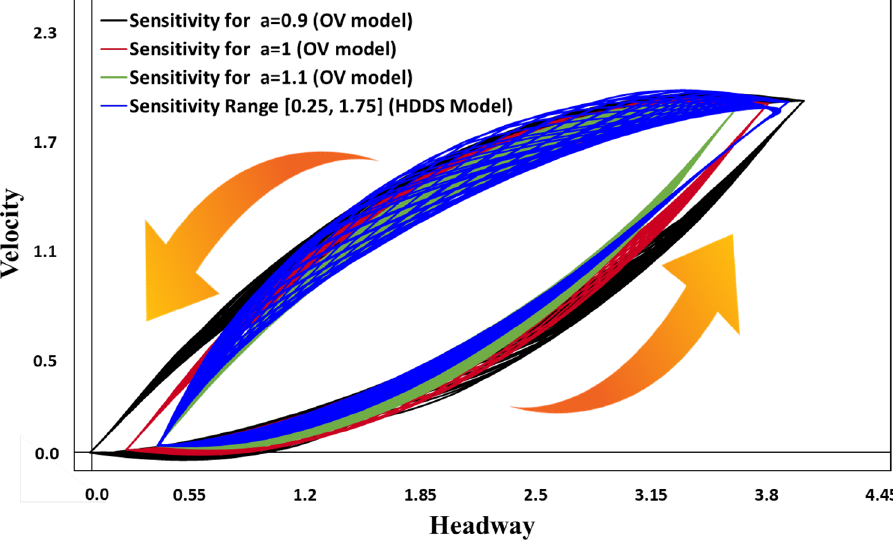
Figure 4. Hysteresis loops for the HDDS model with sensitivity range [0.25, 1.75] and for the conventional OV model with several sensitivities: a = 0.90, 1.00, and 1.10. The upward and downward directed arrows depict the velocity increasing and decreasing tendency